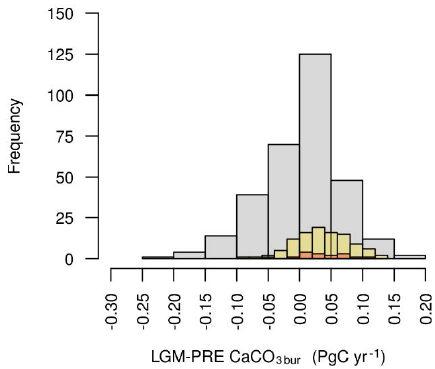
Figure 15. LGM change in deep-sea sediment CaCO 3 burial flux